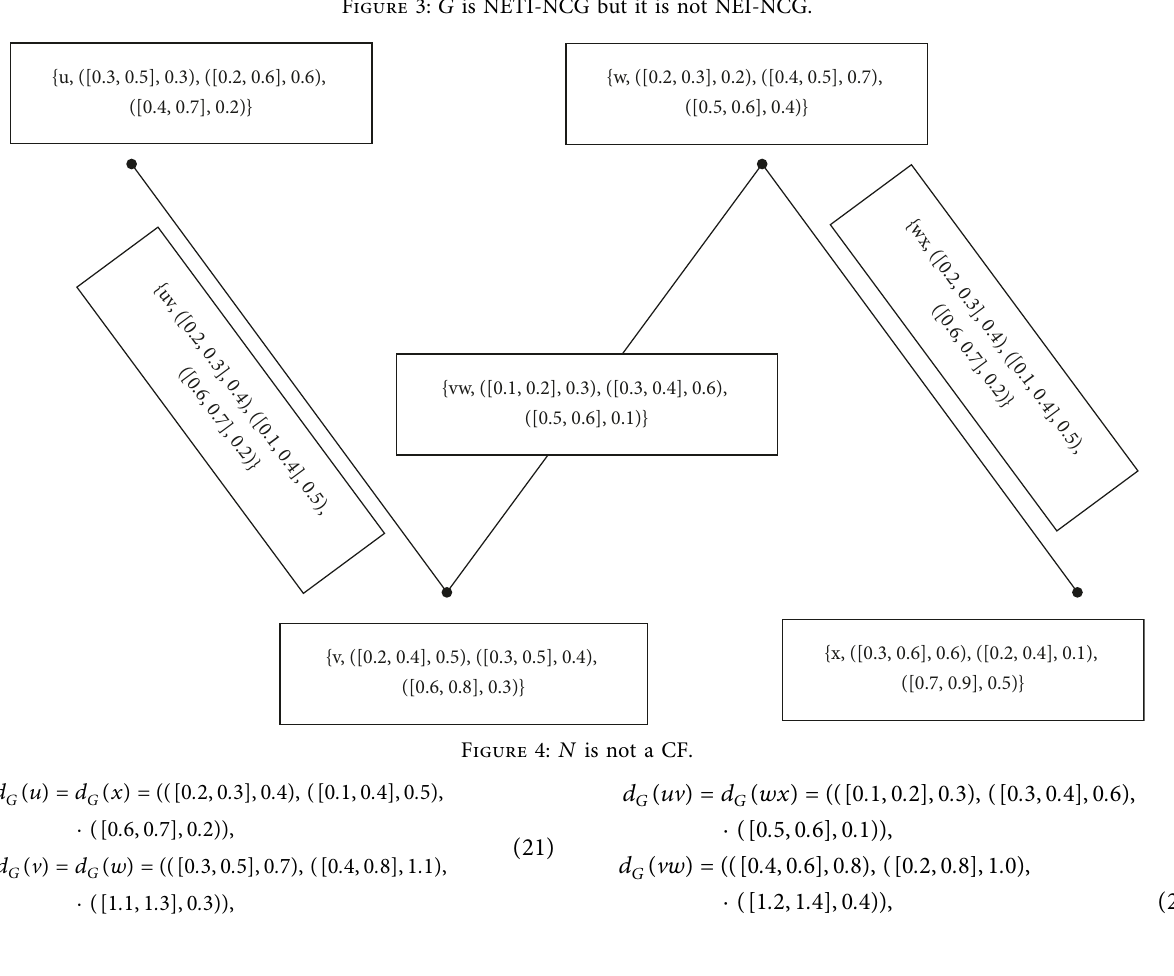
Figure 3: G is NETI-NCG but it is not NEI-NCG.